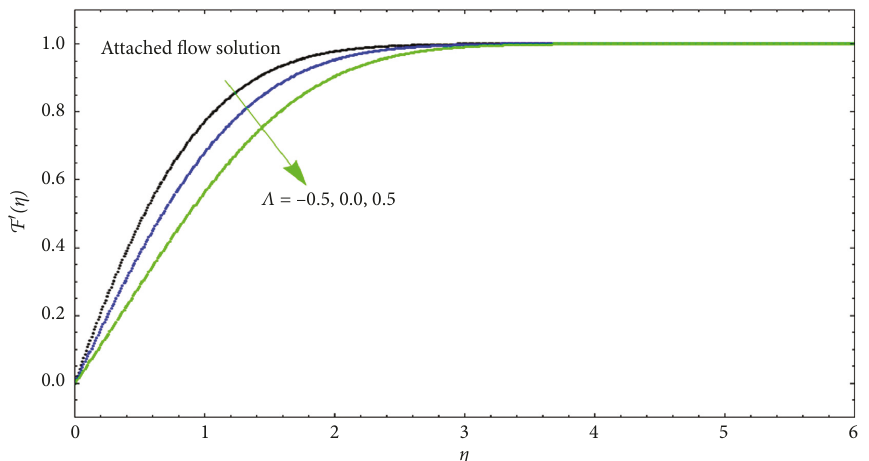
Figure 5: Dissimilarity of F ′ ( η ) being some different values of blowing Λ parameter for only AFS.